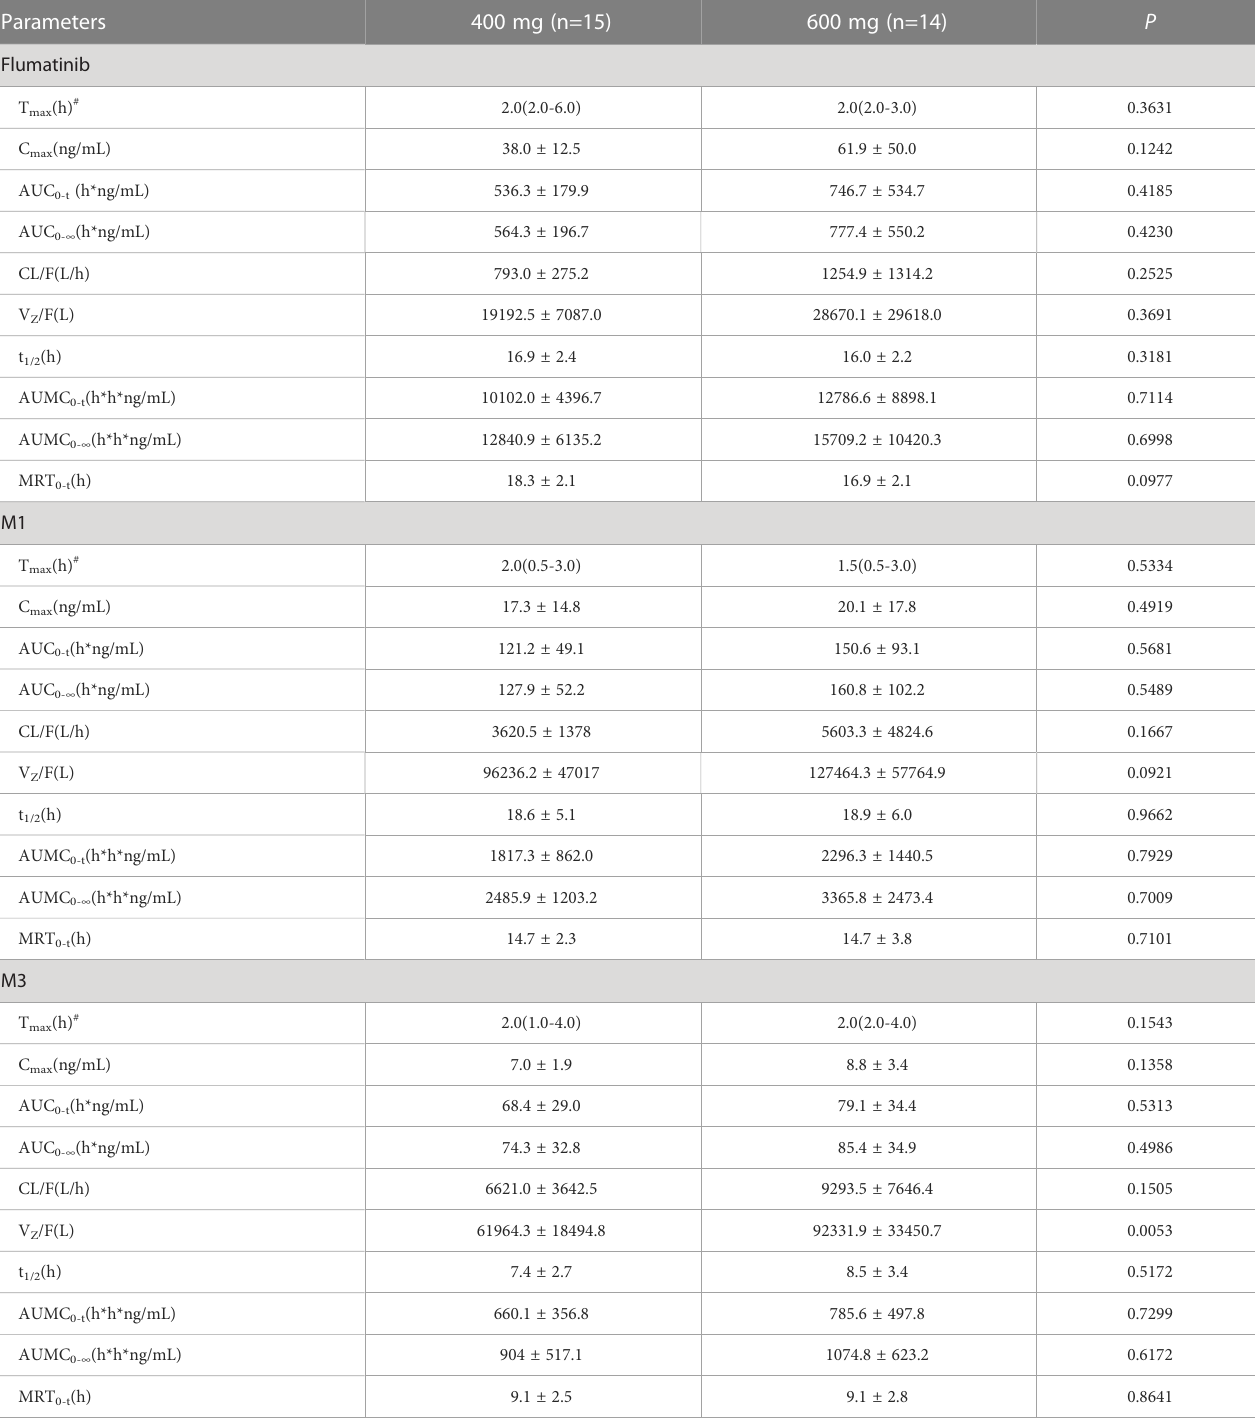
TABLE 2 Pharmacokinetic parameters of fl umatinib and two major metabolites following a single-dose administration.